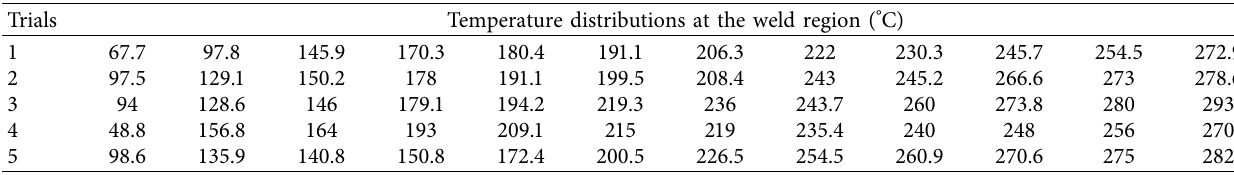
Figure 8: (a) Configuration of specimen preparation and (b) V-Notch sample preparation of Charpy impact Table 5: Temperature at weld regions of each trial.